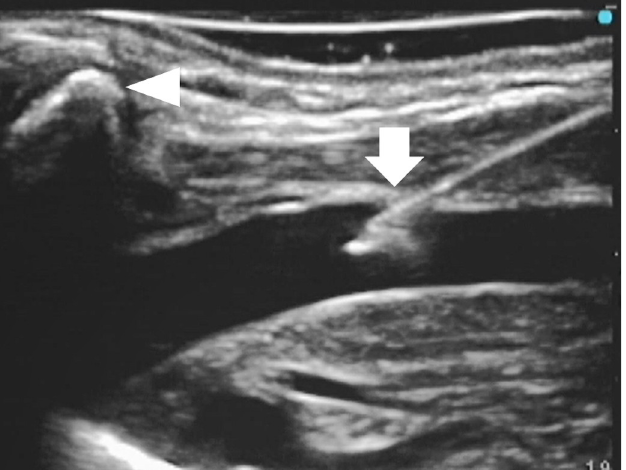
Fig 3. The long-axis view of the internal jugular vein and the needle. The transducer is positioned over the clavicle (arrowhead), and the internal jugular vein and the needle (arrow) are visualized